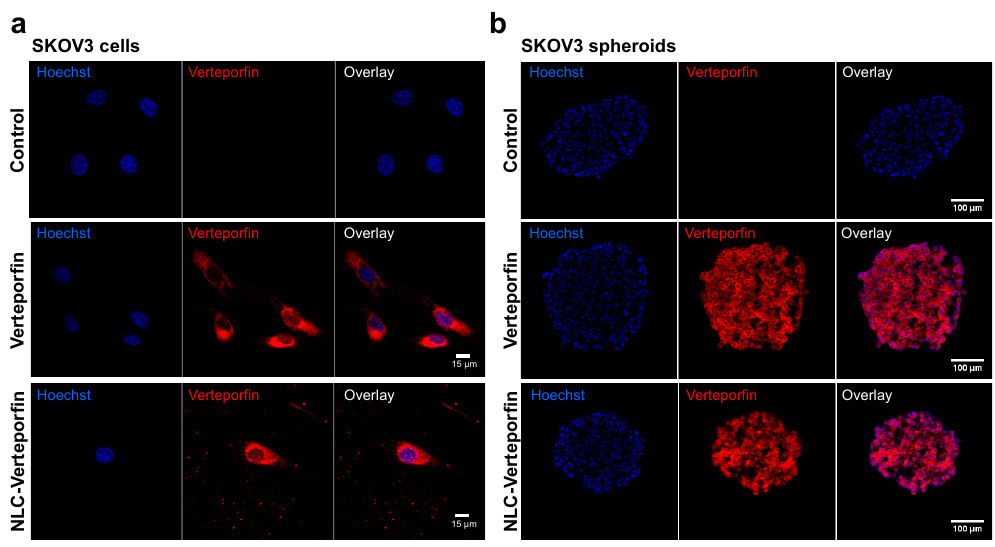
Figure 2. Verteporfin and NLC-verteporfin are internalized in SKOV3 cells and spheroids. Representative confocal microscopy images of SKOV3 cells ( a ) or sections of SKOV3 spheroids ( b ), incubated with 1 µmol.L − 1 verteporfin or NLC-verteporfin for 24 h. Nuclei are stained with Hoechst 33342 (in blue). Verteporfin fluorescence is observed in red. Control: untreated cells or spheroids. 2.3. Verteporfin and NLC-Verteporfin Induce Phototoxicity in Ovarian Cancer Cells and Spheroids Both free verteporfin and NLC-verteporfin induced high phototoxicity in ovarian cancer cells in vitro. Increasing concentrations of free verteporfin or NLC-verteporfin exposed to NIR light reduced the viability of SKOV3 and OVCAR3 cells cultured in monolayers and in spheroids, whereas they had no toxic effect on their proliferation in the dark (Figure 3). The OVCAR3 cells cultured in monolayer appeared to be less sensitive to verteporfin and NLC-verteporfin treatments as compared to SKOV3 cells (Figure 3a,b and Table 2), but interestingly OVCAR3 spheroids were highly sensitive to light exposure 2 h or 24 h after both treatments, with IC 50 values similar to those of SKOV3 spheroids (Figure 3c,d, Table 2 and Figure S3).